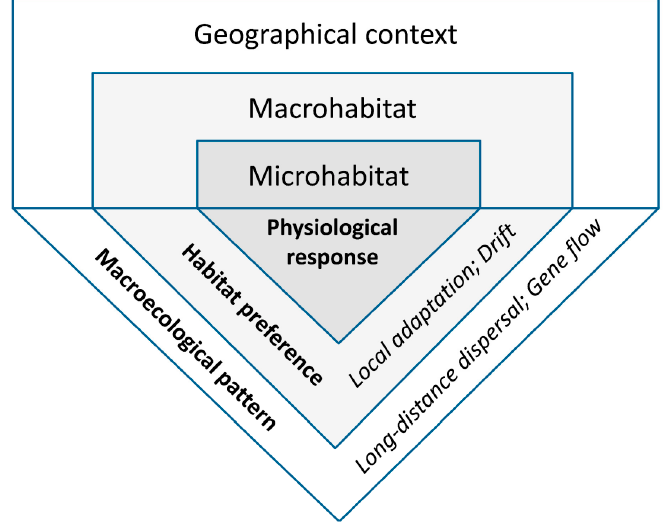
Figure 1. Scale dependence of the main lichen-habitat relationships addressed in this review. The environment affects lichens at three relatively distinct spatial scales ( upper panel ), where their physiological and ecological responses ( lower panel ) can be measured (in Bold ), while the eco-evolutionary processes can be typically only inferred (in Italics ).